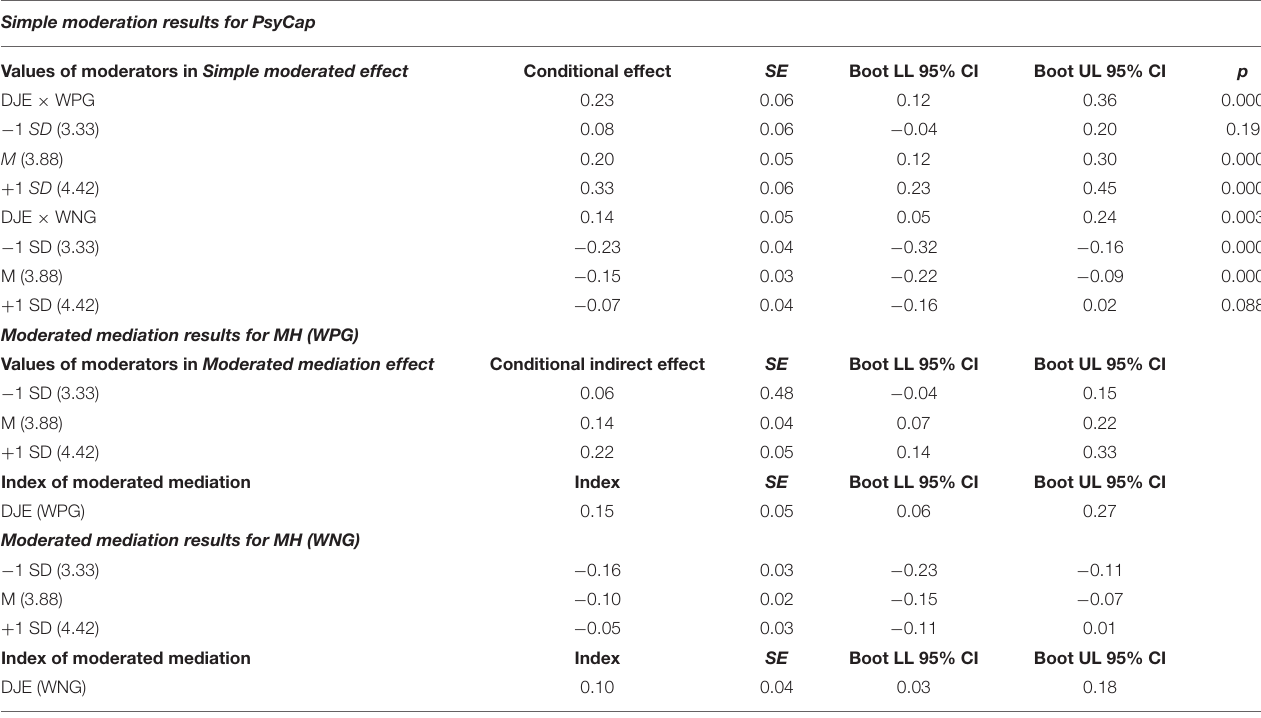
TABLE 4 | Regression results for moderation ( N = 222).